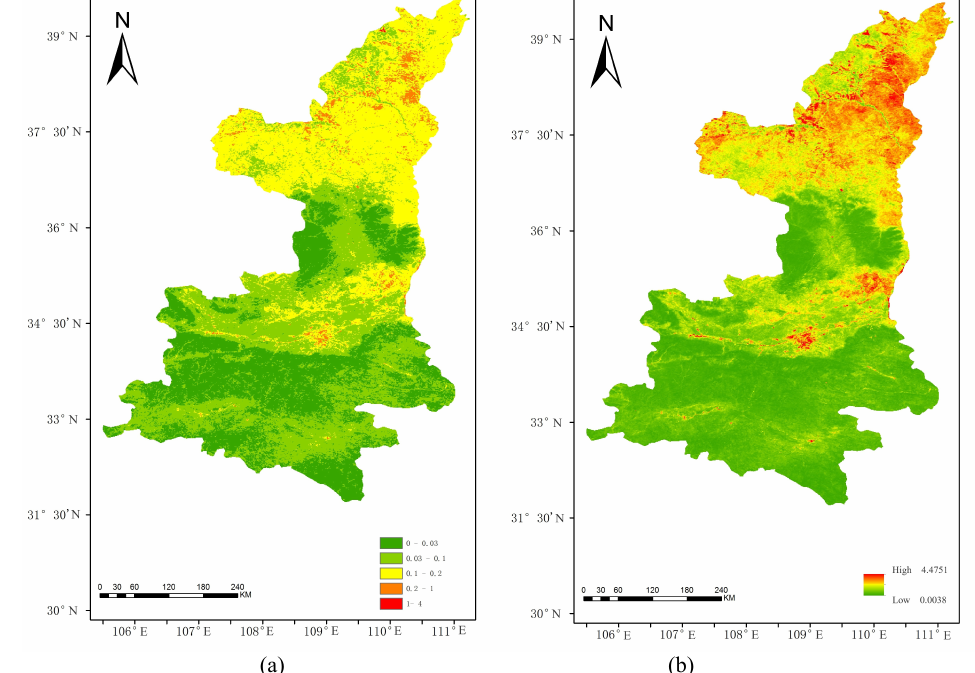
Figure 2. Stability analysis diagram of Shaanxi NDVI （ a ） NDVI coefficient of variation （ b ） NDVI stability